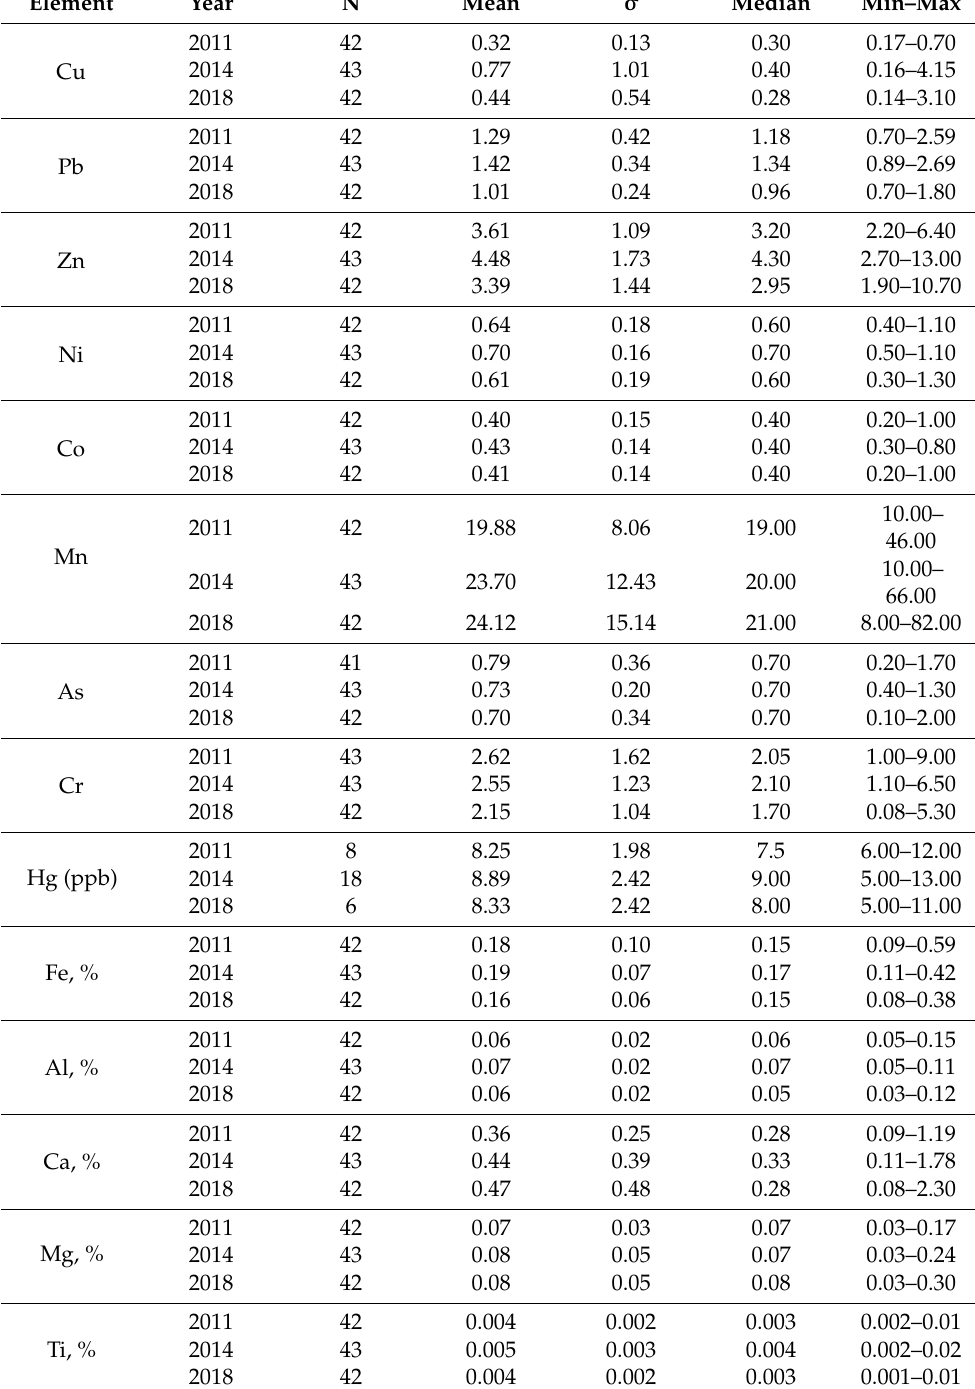
Table 1. Trace element concentrations of the surface sediments collected on the beach along the coast of the south-eastern Baltic Sea coast (Lithuania) in 2011–2018 (values in ppm unless otherwise